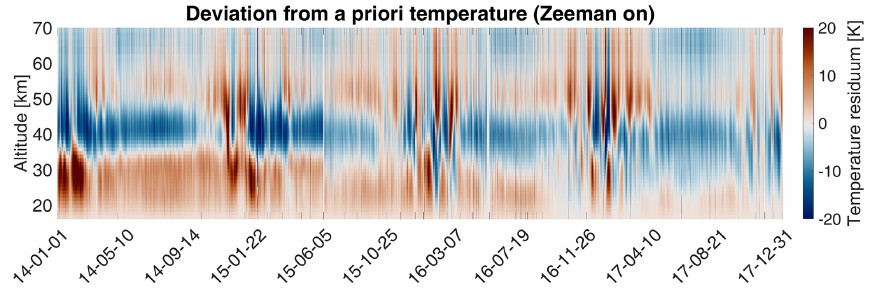
Figure 5. Absolute differences between retrieved TEMPERA profiles and a priori profiles. Reddish regions indicate higher values for the retrieved quantities in comparison to the a priori ones. Bluish areas support colder temperatures concerning the a priori